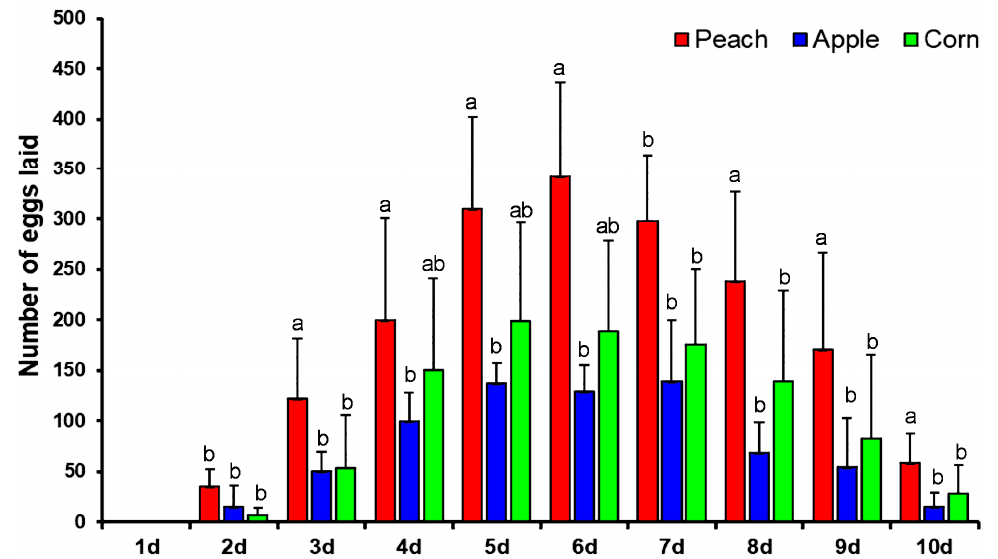
Figure 1. Oviposition of yellow peach moth on peach, corn and apple. Vertical bar under different letters are significantly different and same letters are not significantly different (Tukey’s, P < 0.05).